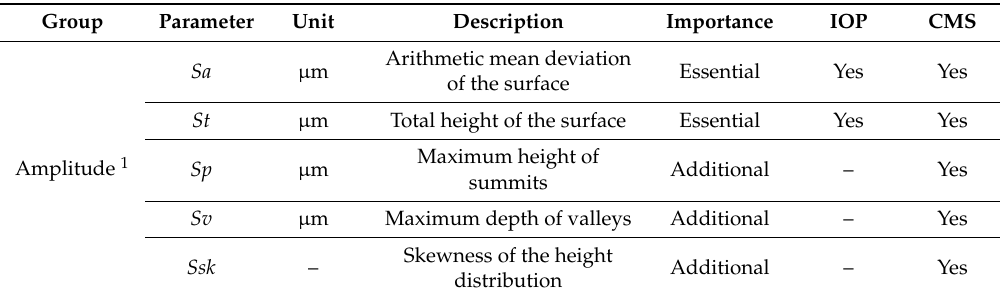
during the precision grinding process realized in a 5-axis CNC grinding